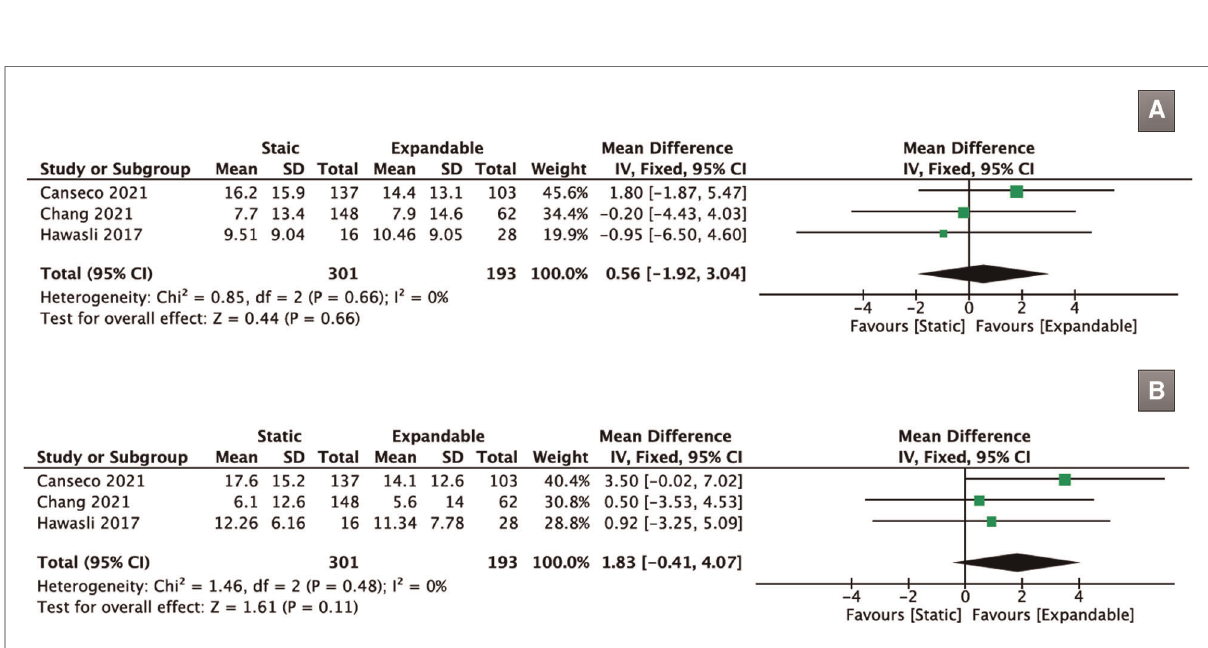
FIGURE 8 Forest plots for comparison of PI-LL mismatch at preoperative ( A ) and fi nal follow-up ( B ) between the static and expandable